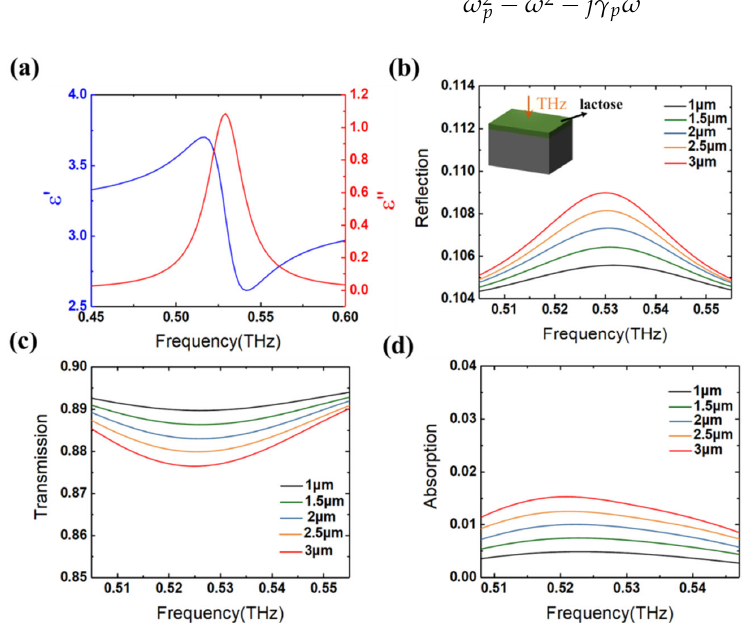
Figure 3. The dielectric constant of the α‐ lactose and the response characteristics of the lactose films coated on the metasurface. ( a ) Dielectric constant of α‐ lactose; ( b ) reflection, ( c ) transmission, and ( d ) absorption of the lactose ‐ coated quartz substrate.